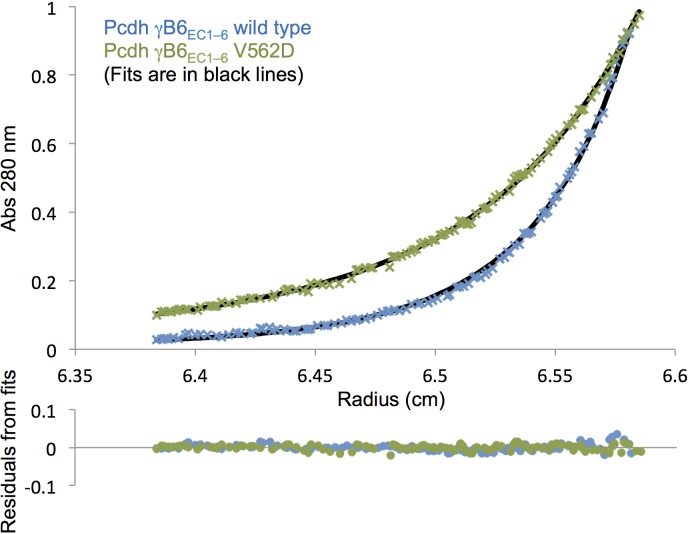
Analytical ultracentrifugation data of γB6EC1–6 wild-type and V562D cis mutant.Representative sedimentation equilibrium analytical ultracentrifugation data for the γB6EC1–6 wild-type and V562D cis mutant (γB2 numbering). UV scans taken at 13000 rpm for a protein concentration of 9.6 µM (0.75 mg/mL) are shown in the top chart. The V562D mutant data (green crosses) was fitted to a monomer-dimer model, and the wild-type data (blue crosses) was fitted to a monomer-dimer-tetramer model. Fits are shown as black lines with the residuals from fitting shown in the chart below.